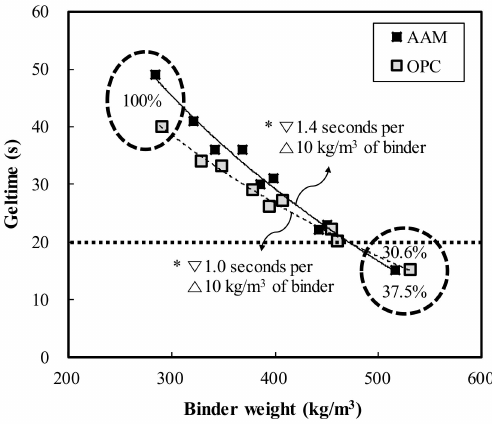
Figure 4. Geltime of OPC and AAC as a function of binder